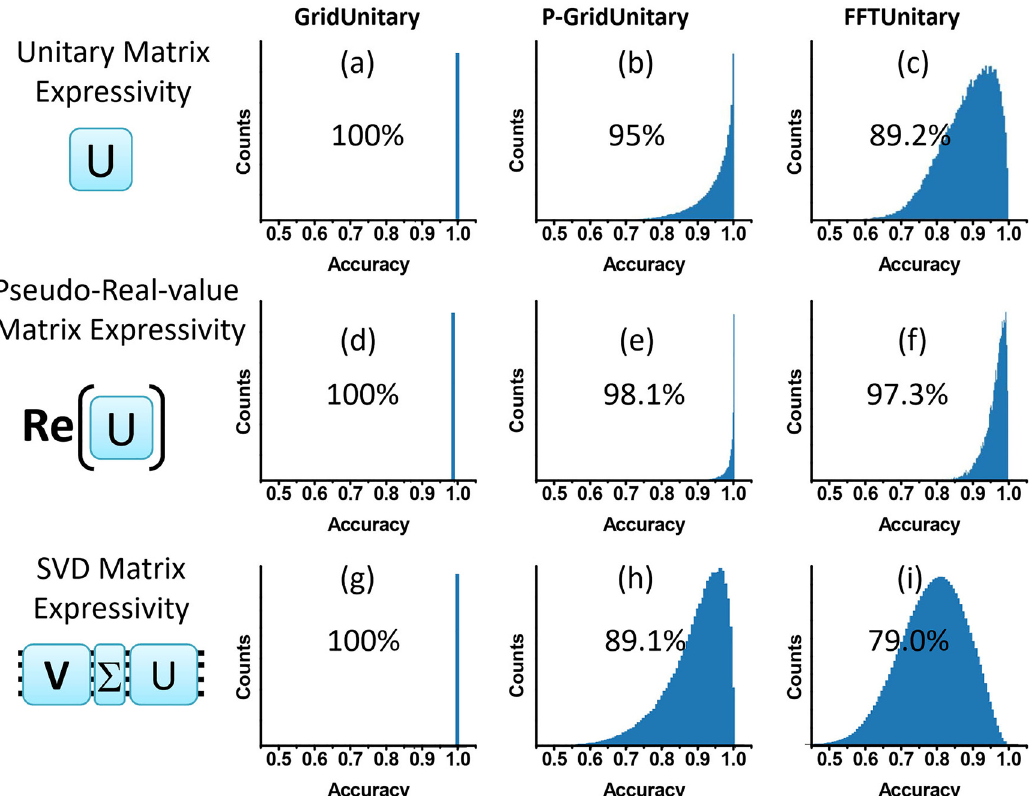
Figure 2: The statistical accuracy distribution of expressing 4*4 unitary matrix by (a) GridUnitary mesh, (b) P-GridUnitary mesh, and (c) FFTUnitary mesh; the statistical accuracy distribution of expressing real-value matrix by real-part of (d) GridUnitary mesh, (e) P-GridUnitary mesh, and (f) FFTUnitary mesh. The statistical accuracy distribution of expressing real-value matrix by conventional SVD matrix with (g) GridUnitary mesh, (h) P-GridUnitary mesh, and (i) FFTUnitary mesh as the unitary matrix